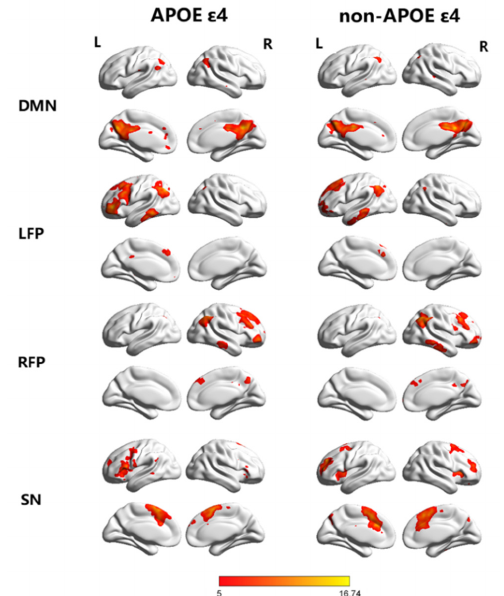
Figure 2. Group ICA estimated resting-state patterns grouped as the default mode network (DMN), left frontoparietal network (LFP), right frontoparietal network (RFP) and salience network (SN) in each group (Color-coded were t value, p < 0.05, Family Wise Error (FWE) corrected; L/R, left/right